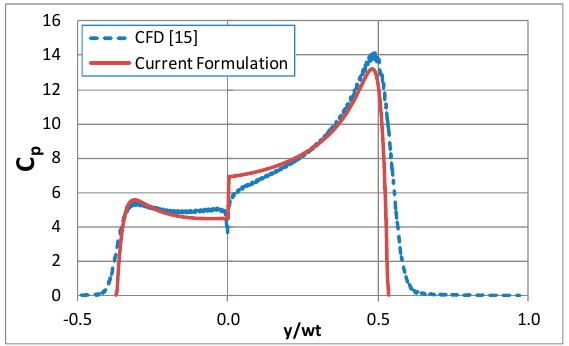
Figure 11. The pressure distribution during impact with horizontal velocity β 1 = 20 ◦ , β 2 = 30 ◦ , and v / w = − 0.50.